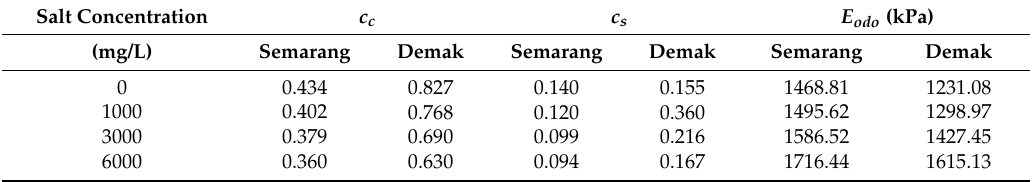
Table 2. Compression index, swelling index and oedometer modulus of Semarang-Demak clay.